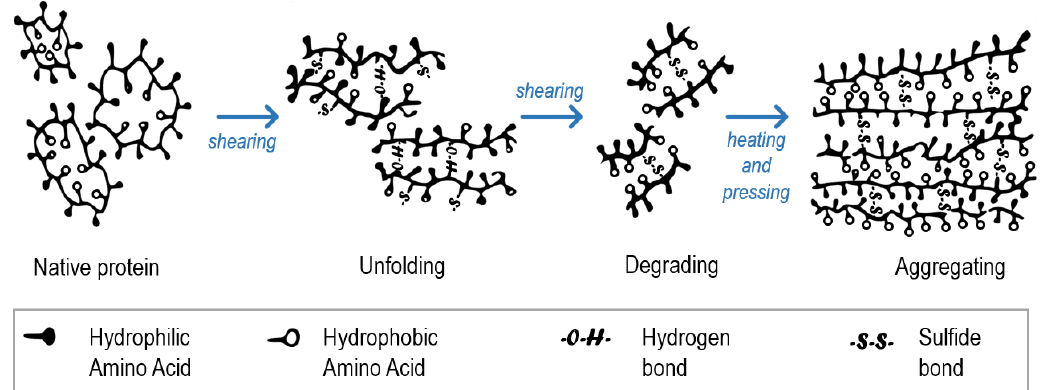
Figure 1. Changes in protein conformation during extrusion of HMMA. Modified illustration adopted from Zhang et al. [17].